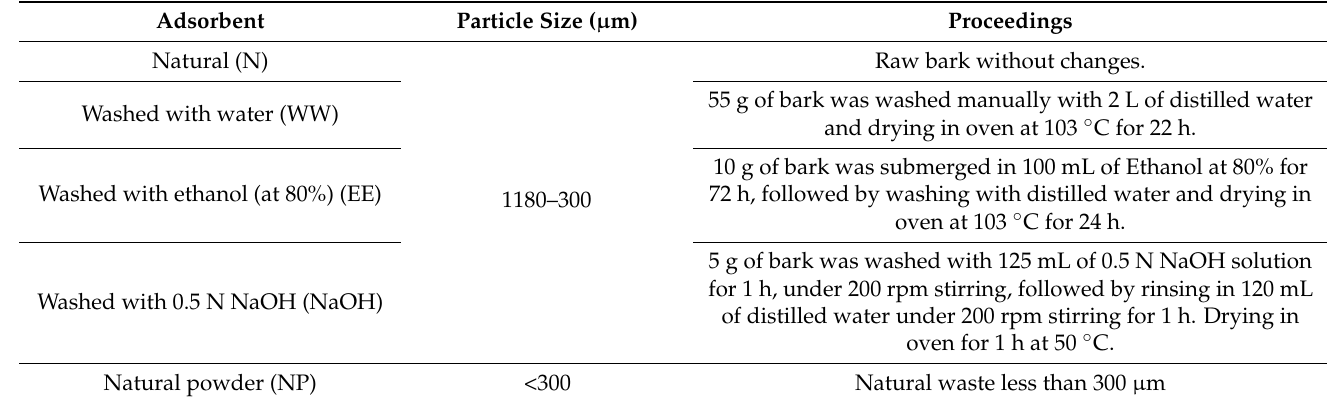
Table 1. Chemical and physical modification processes of the adsorbents tested in the